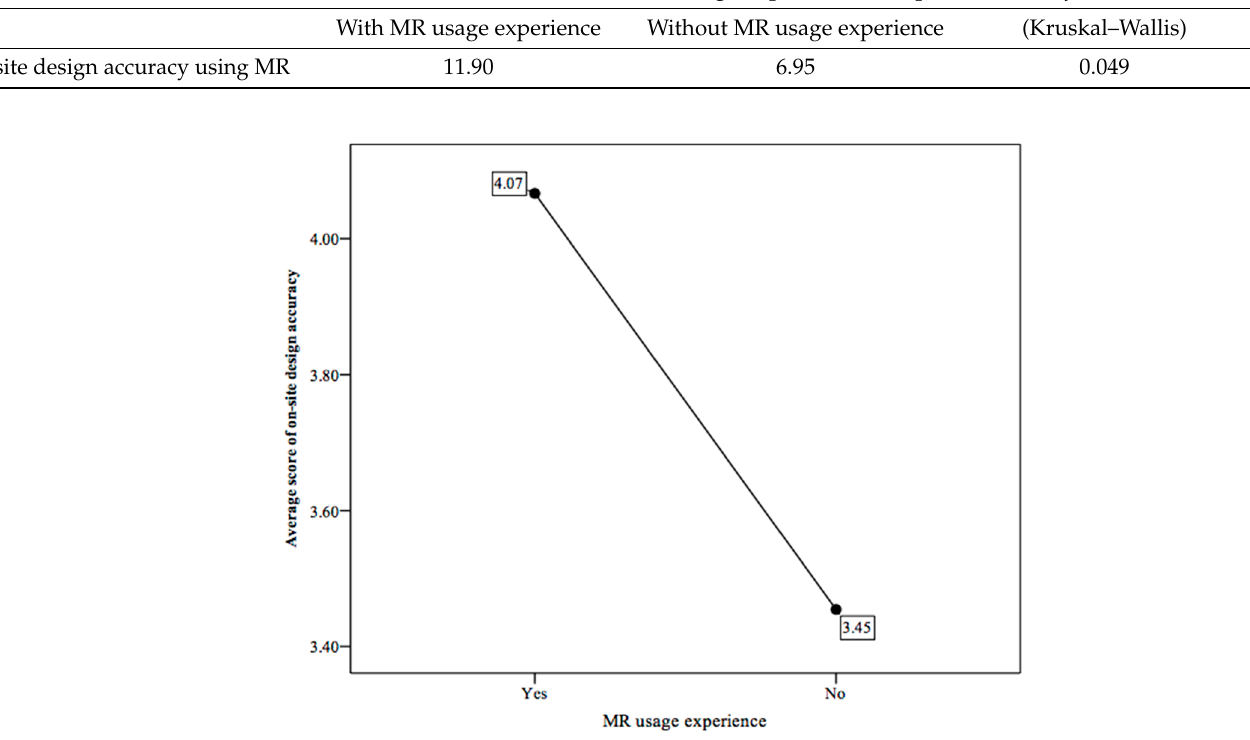
Figure 12. The average scores for on-site design accuracy using MR in different MR usage experi- ence groups. Table 4. The Kruskal–Wallis test for different design experience groups in on-site design accuracy using MR. Mean Ranks of Scores for the Design Experience Groups